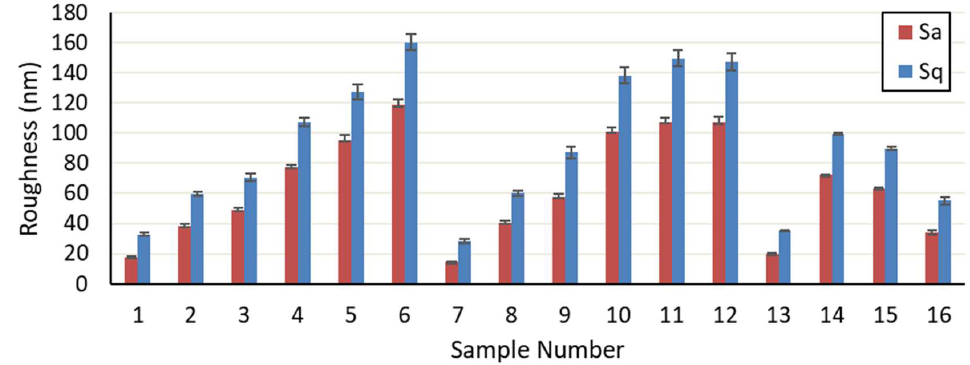
Figure 8. Roughness-measurement result using Talysurf CCI HD.